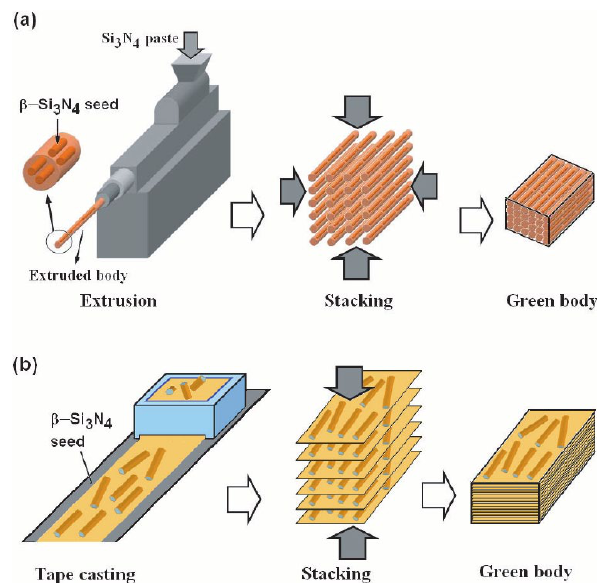
Fig. 11 Schematic diagrams of preparing Si 3 N 4 green bodies containing oriented β-Si 3 N 4 seeds by (a) extrusion and (b) tape casting. Reproduced with permission from Ref. [23], © National Institute for Materials Science